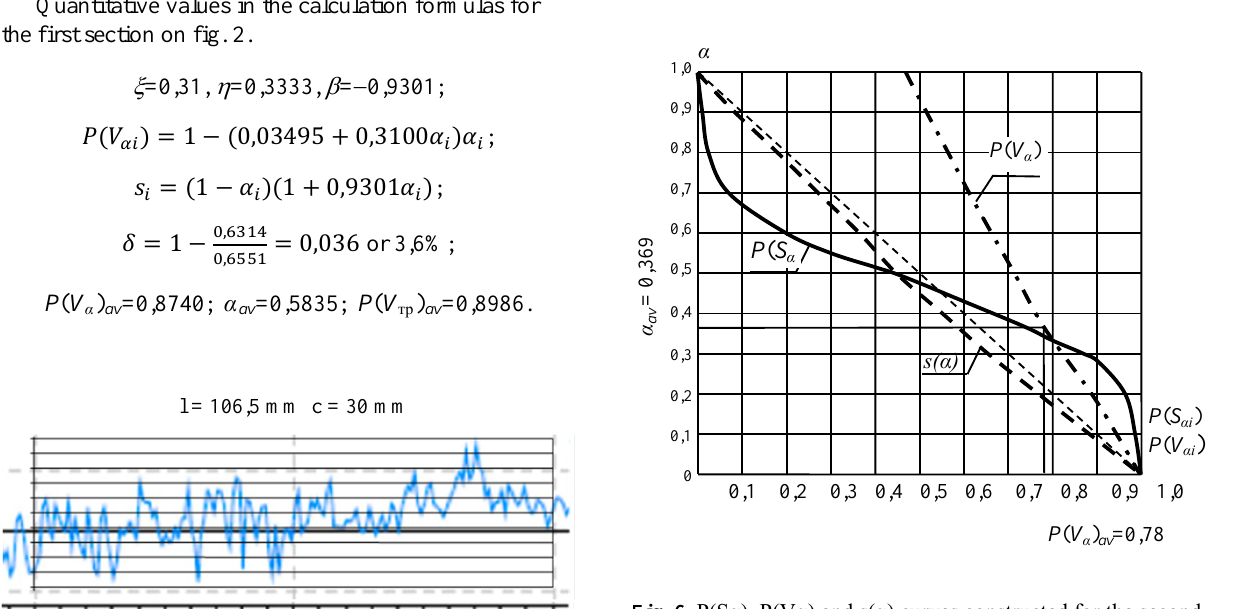
Fig. 6. P(Sα), P(Vα) and s(α) curves constructed for the second section of the profilogram depicted on fig. 2. Quantitative values in the calculation formulas for the second section on fig. 2.